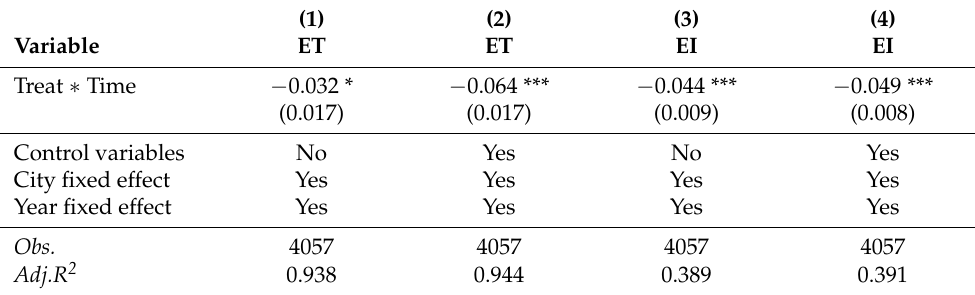
Table 4. PSM-DID estimation